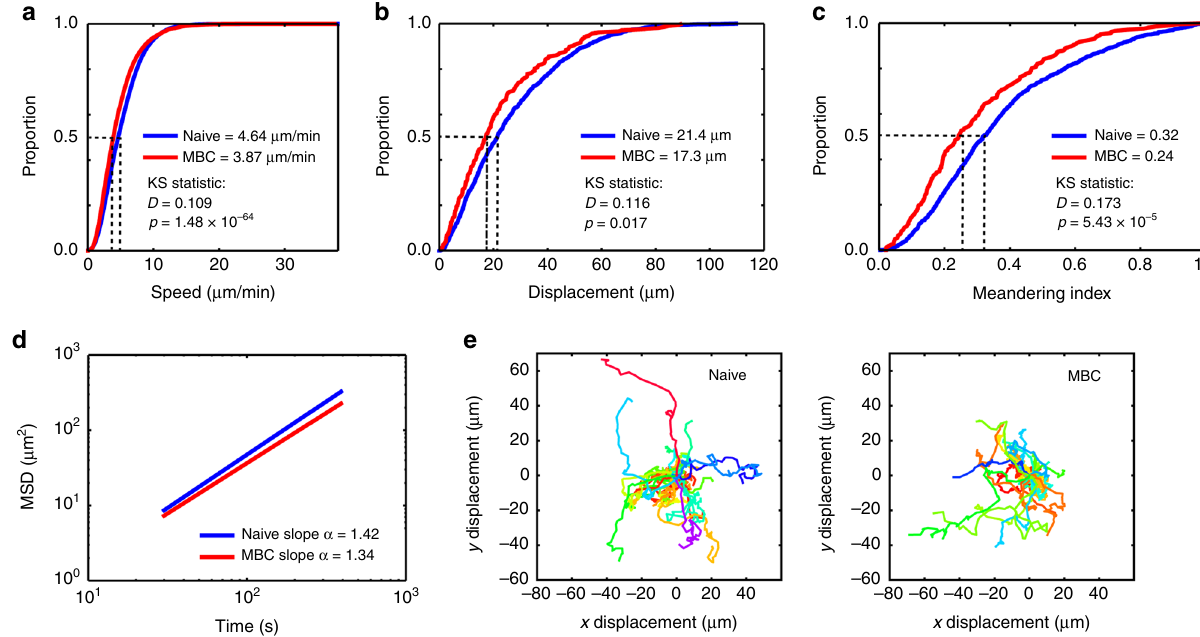
Fig. 2 Naive and MBCs use a superdiffusive search strategy for antigen. a Cumulative distribution function (CDF) plot of speed for naive (blue) and MBCs (red). b CDF plot of displacement for naive (blue) and MBCs (red). c CDF plot of meandering index for naive (blue) and MBCs (red). KS statistics refer to Kolmogorov – Smirnov statistics. d Mean squared displacement (MSD) plot of naive (blue) and MBCs (red). All data are pooled from three independent movies. e Representative tracks for naive (left) and MBCs (right). Data are representative of >3 independent